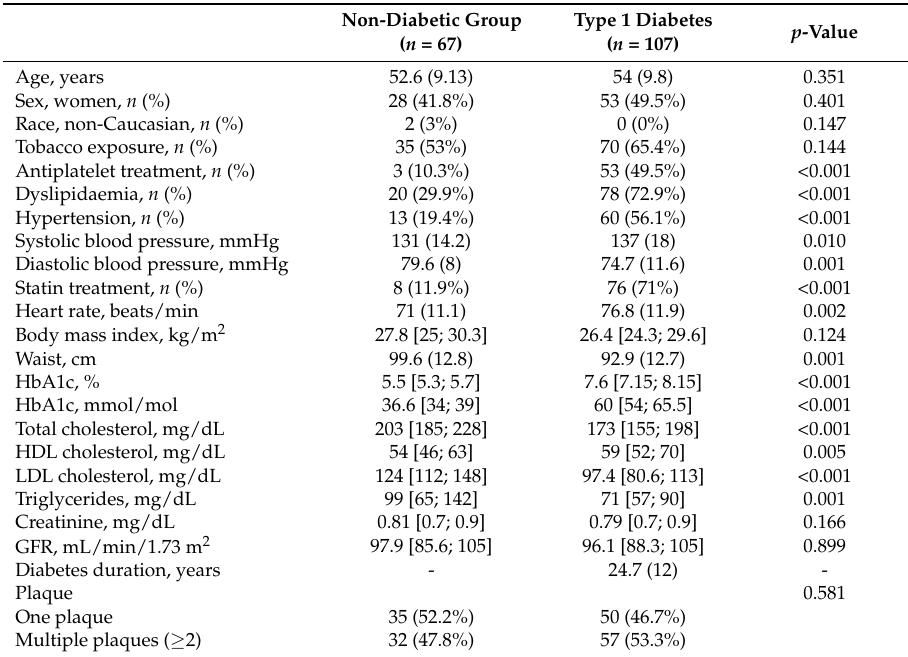
Table 1. Baseline characteristics of the